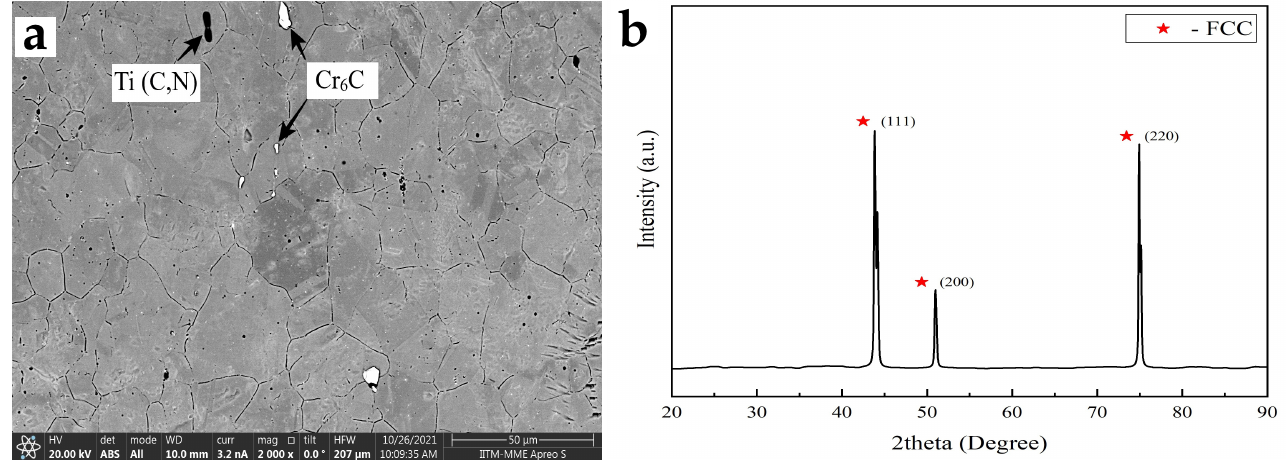
Figure 1. ( a ) Initial SEM micrograph and ( b ) XRD pattern of sample IN